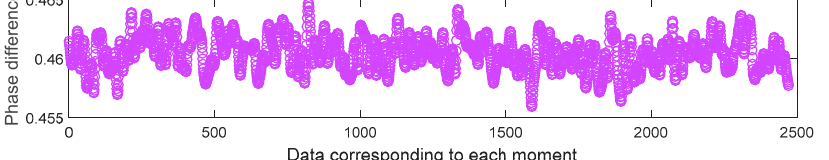
Figure 4. Test of influence of power on/off on L1 phase difference results between channels.